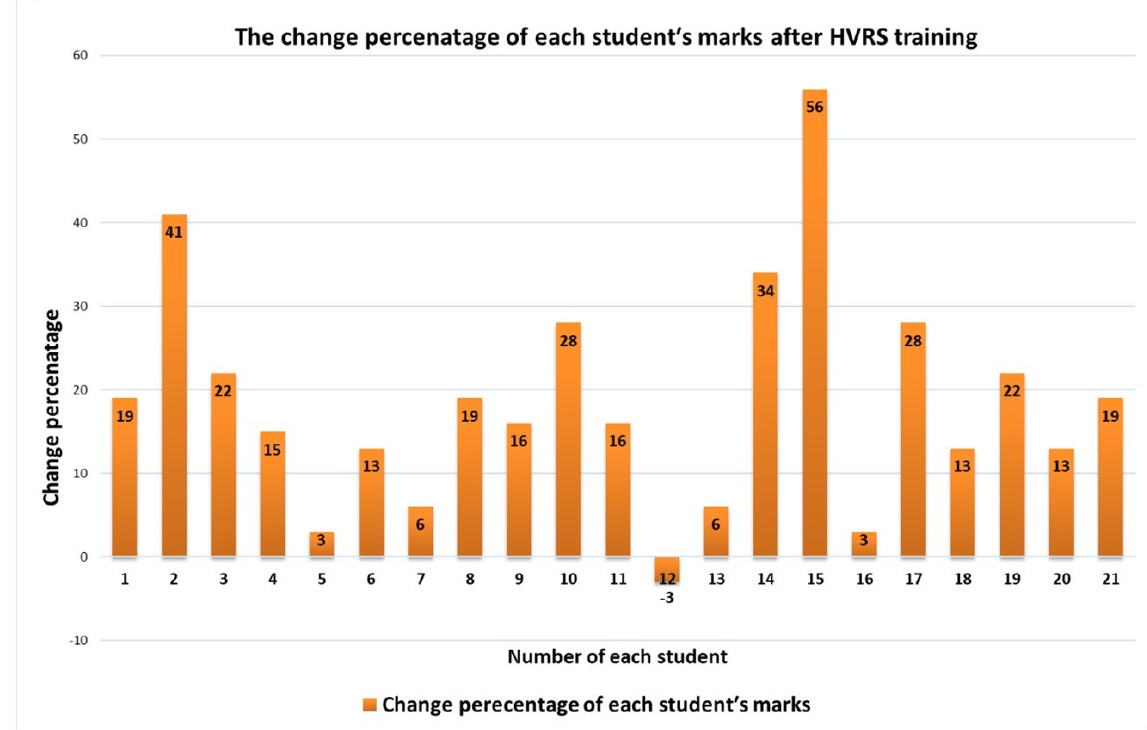
Figure 4. The change of each students ′ mark percentage after HVRS training.